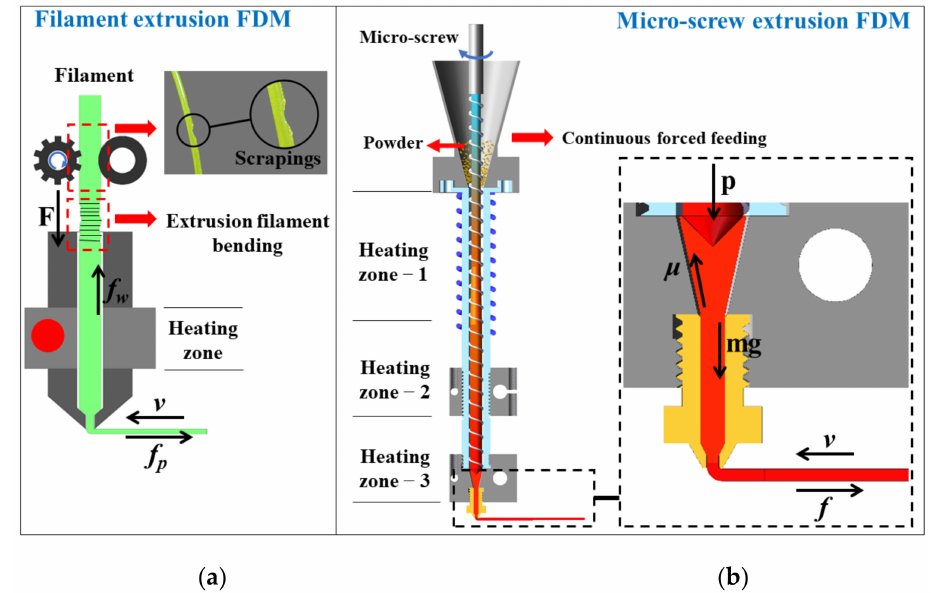
Figure 1. Schematic diagram of ( a ) filament extrusion and ( b ) micro-screw extrusion FDM. In feeding part, filament extrusion requires a specific filament diameter (1.75 or 3